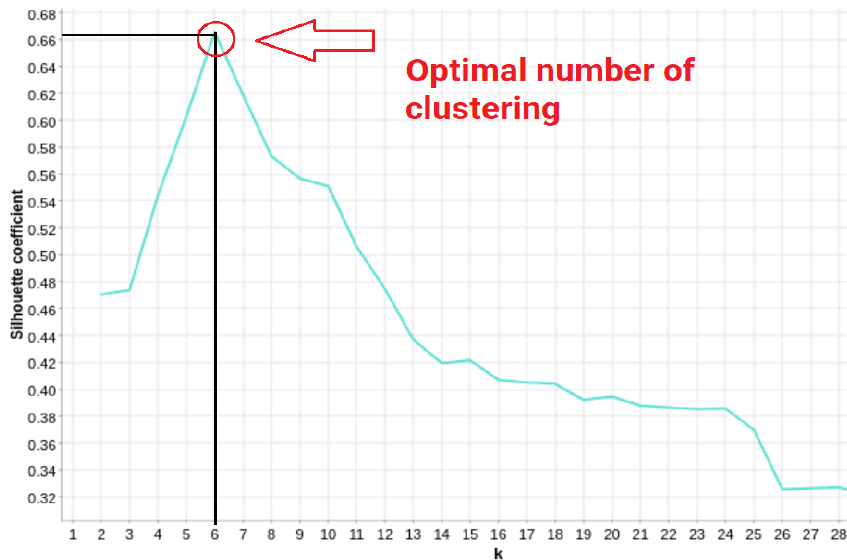
Figure 8. An example silhouette